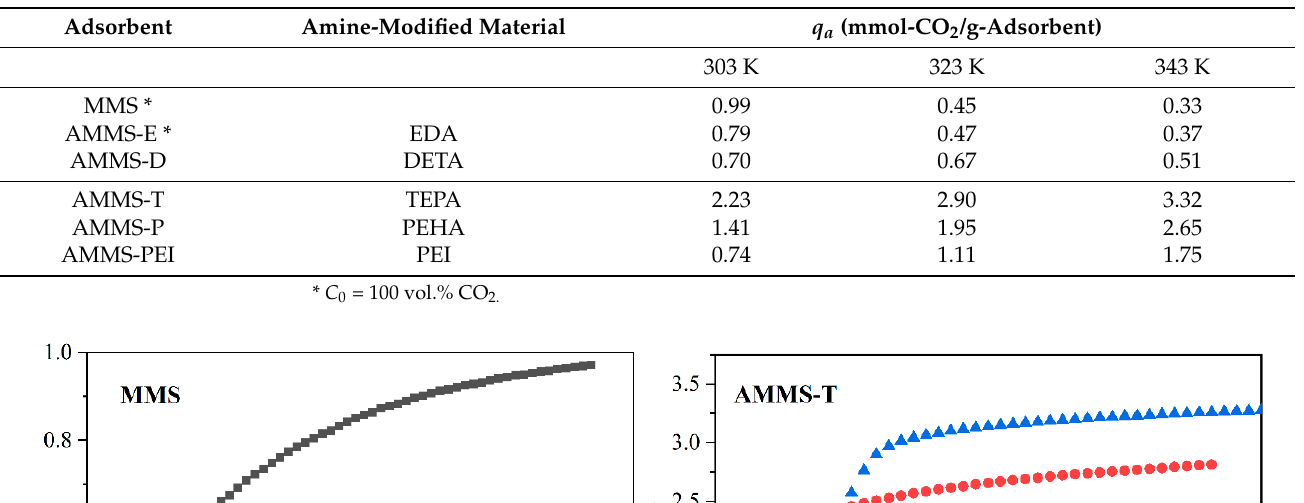
Table 3. The CO 2 adsorption capacity of MMS and AMMS.